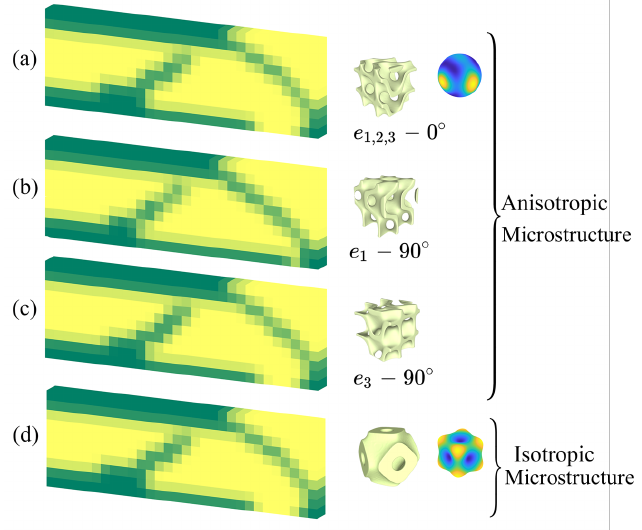
Figure 10. Rotating orthotropic cellular material compared with isotropic